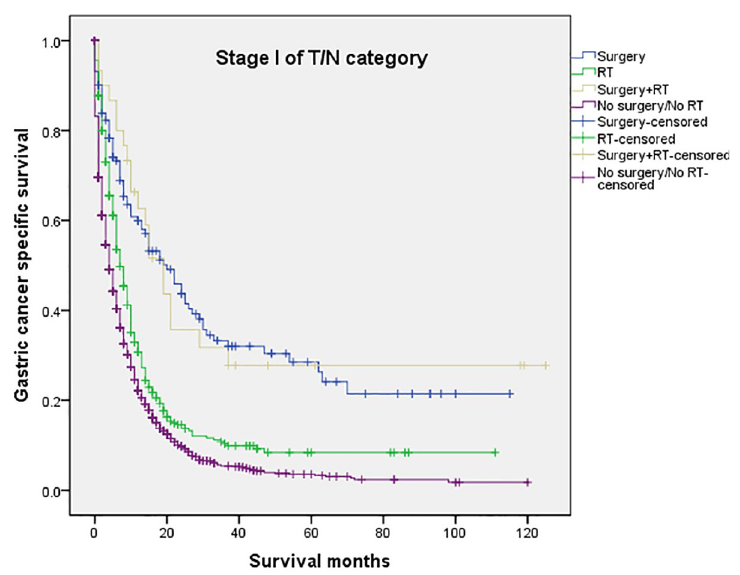
Fig 2. Survival curves in patients with advanced gastric cancer according to four subgroups in stage I of T/N category (P < 0.001). RT: radiation.